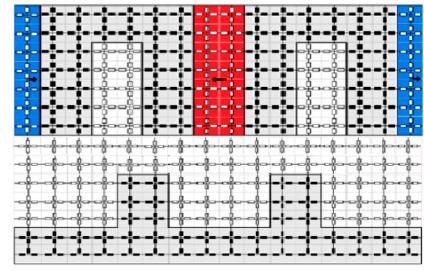
Figure 9. Meshed AFSPM linear structure.